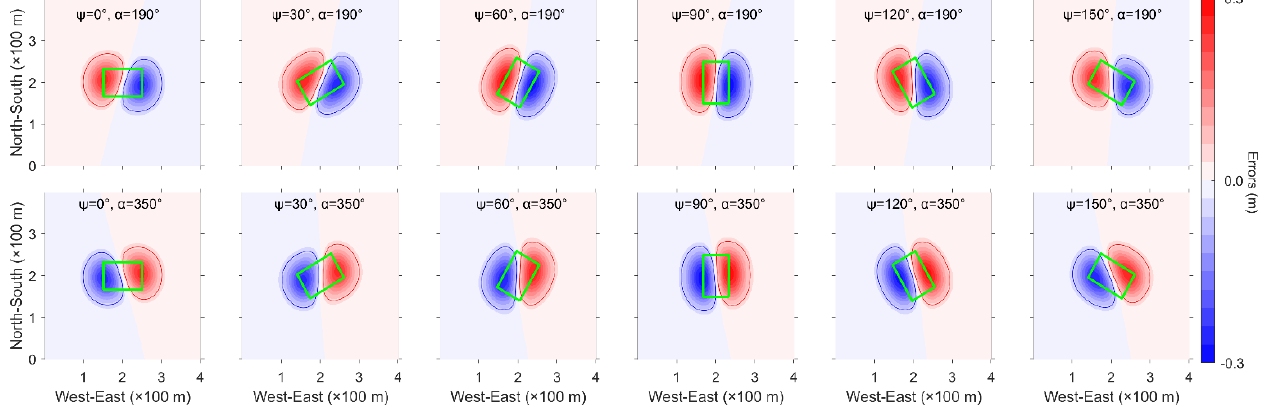
Figure 4. Assessed errors of the NOV-estimated mining subsidence for descending (i.e., 190 = ) and ascending (i.e., α = 350 ◦ ) flight angles with respect to varied advancing directions (i.e., ϕ = 0 ◦ , 30 ◦ ,60 ◦ ,90 ◦ ,120 ◦ ,150 ◦ ).